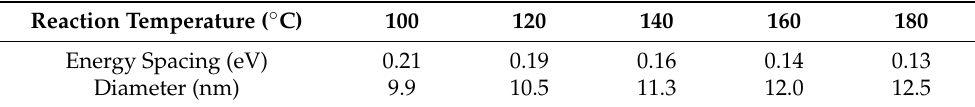
Table 1. Energy spacing and diameter for CsPbBr 3 perovskite NCs prepared at different reaction